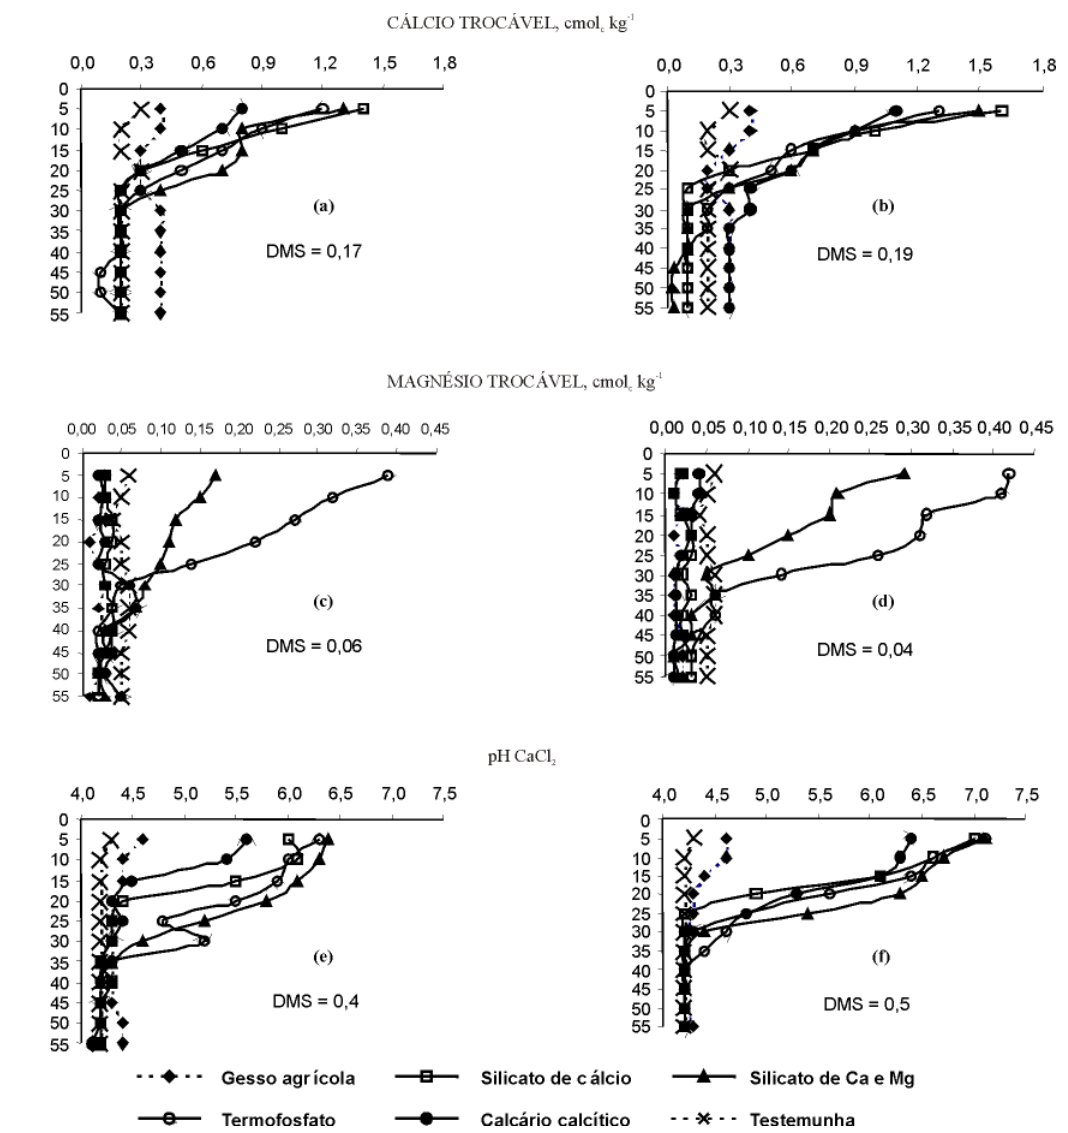
Figura 1. Dinâmica do cálcio (a, b), magnésio (c, d) pH – CaCl aplicação de 500 (a, c, e) e 1.000 kg ha -1 (b, d, f) de cálcio, na forma de corretivos e condicionadores de